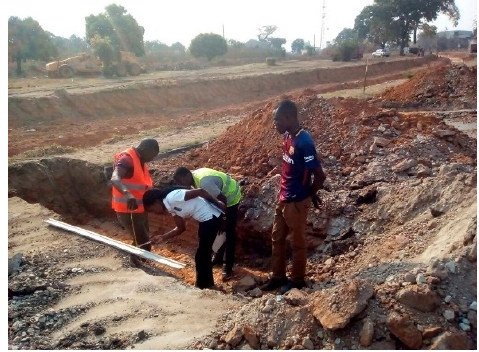
Figure 4. Trench measurements of Pit 1 (Kitwe-Ndola).